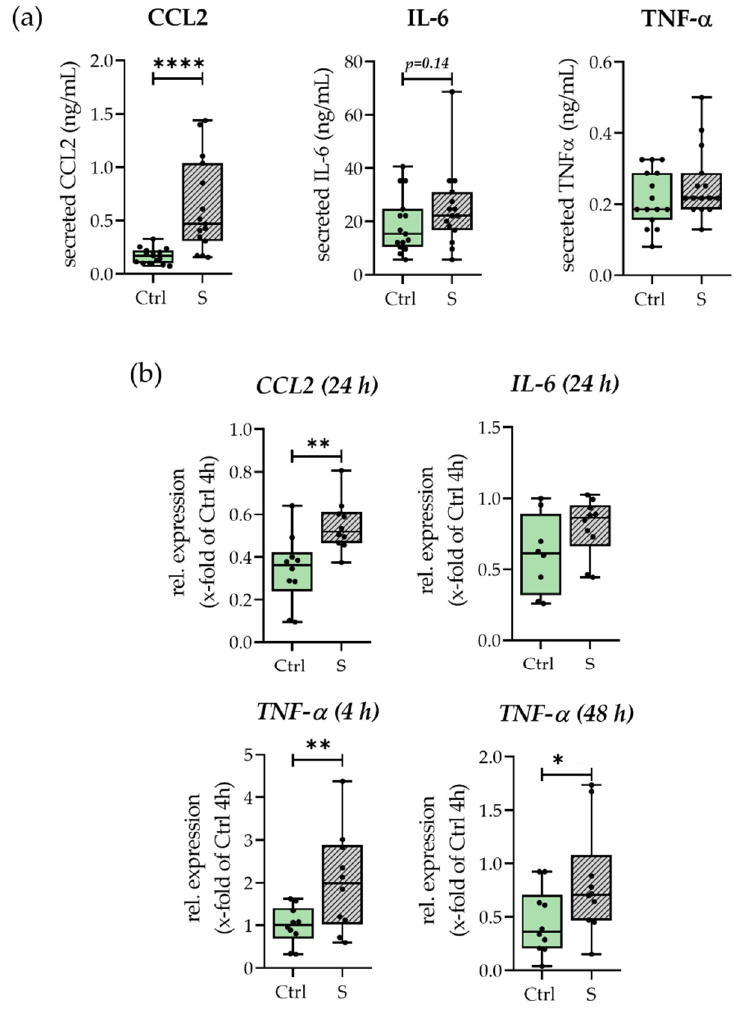
Figure 3. Influence of smoking conditions on inflammation. With ( a ) Secretion of CCL2, TNF- α , and IL-6 after 48 h. N = 5, n = 3. ( b ) Expression of IL-6 , TNF- α , and CCL2 . Shown time points are indicated in graphs. N = 5, n = 2. * p < 0.05, ** p < 0.01, **** p < 0.0001.